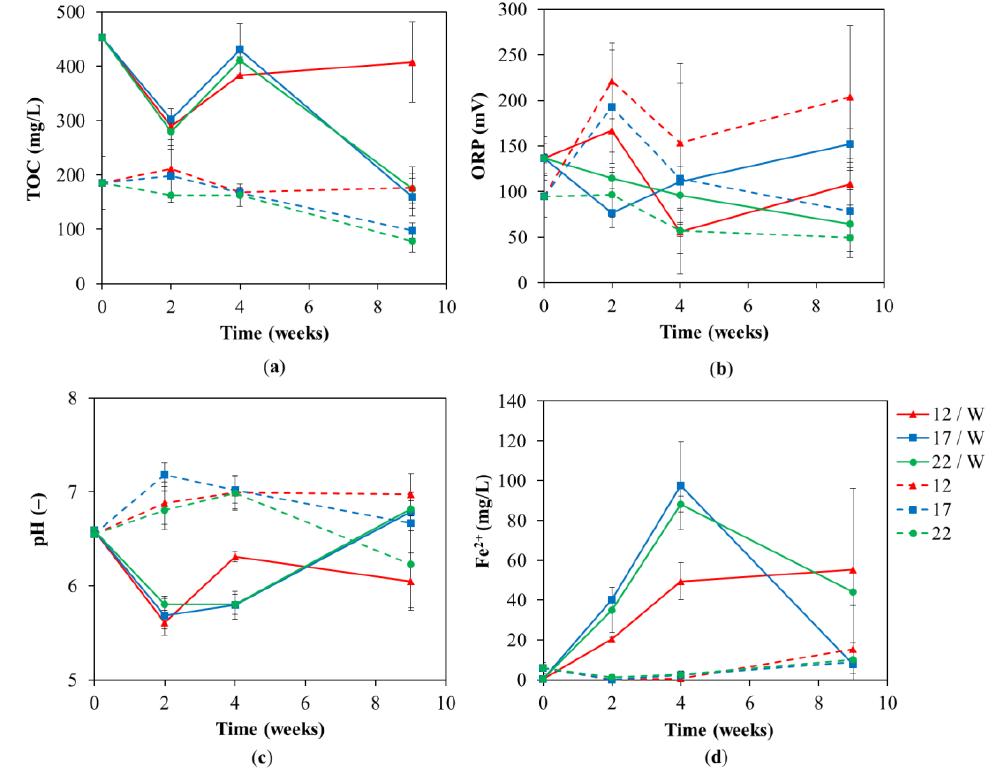
Figure 4. ( a ) Total organic carbon (TOC), ( b ) redox potential (ORP), ( c ) pH and ( d ) Fe 2+ concentration in the groundwater at different lab test temperatures of 12 °C, 17 °C and 22 °C during the lab-scale test with and without whey addition.